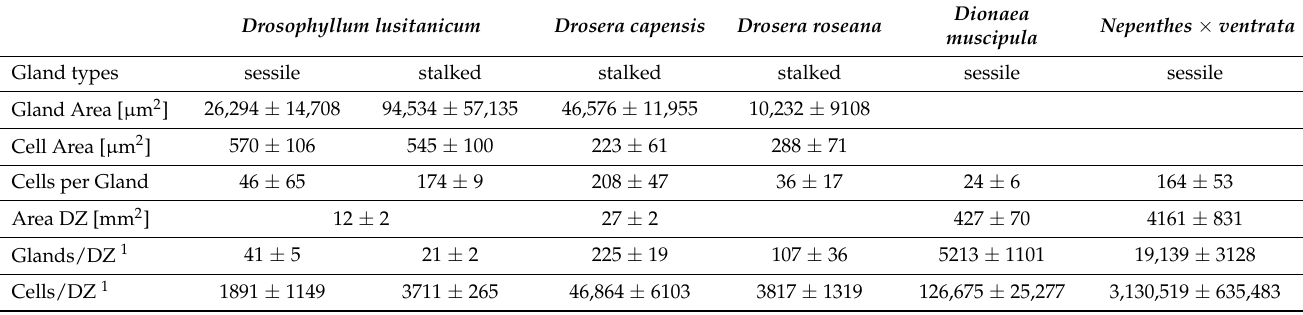
Table 1. Quantification of digestive glands and glandular cells (arithmetic mean ± standard devia- tion). DZ: digestive zone, comprising entire traps in D. roseana , D. muscipula , N. × ventrata , and 1 cm in D. capensis , 0.5 cm in D. lusitanicum . Gland area and cell area of D. muscipula and N. × ventrata are not filled out since number of cells per gland was counted